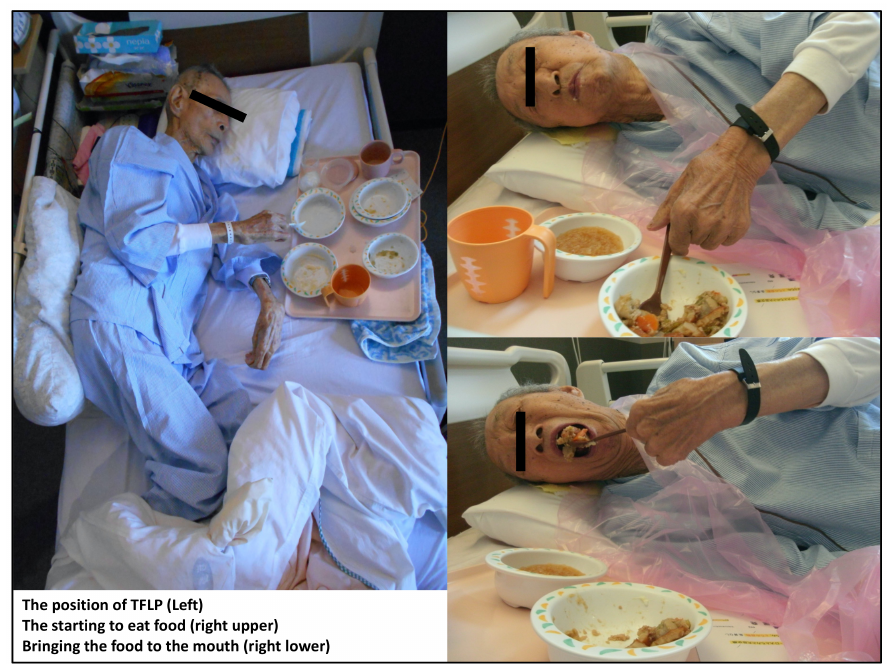
Figure 1. The process of temporal flat lateral position. TFLP; temporal flat lateral